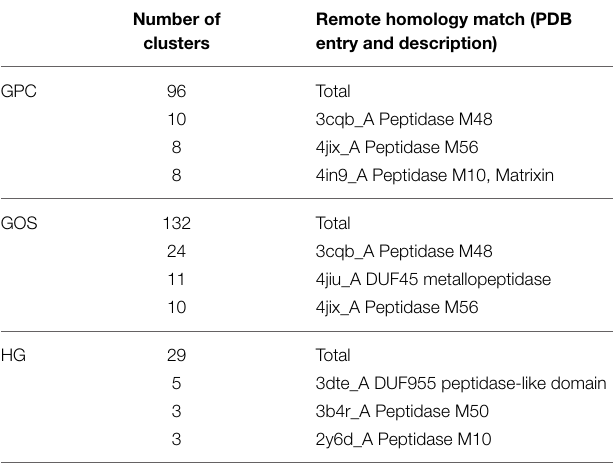
TABLE 4 | Predicted ORFan clusters with the HExxH motif and remote homology to metalloprotease structures. Number of Remote homology match (PDB clusters entry and